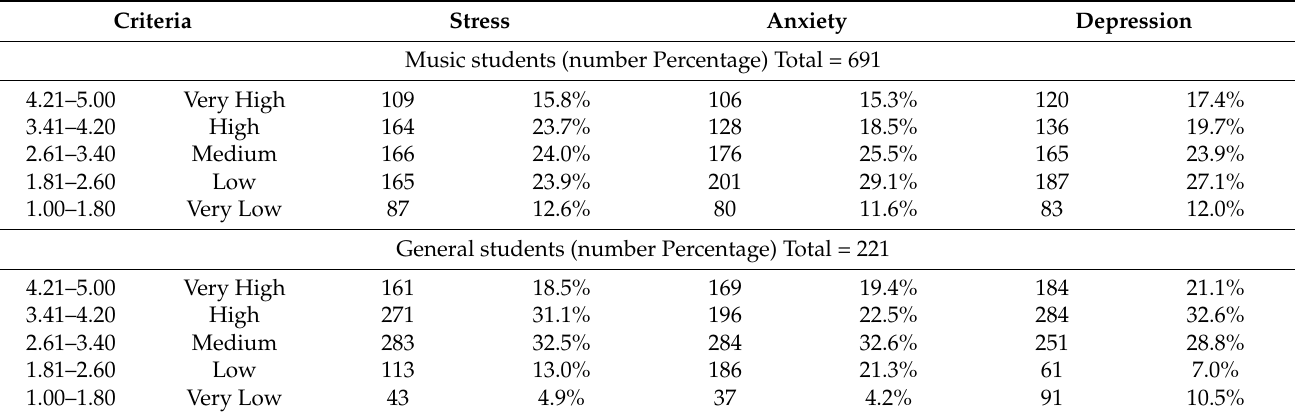
Table 1. Descriptive statistics of mental health.